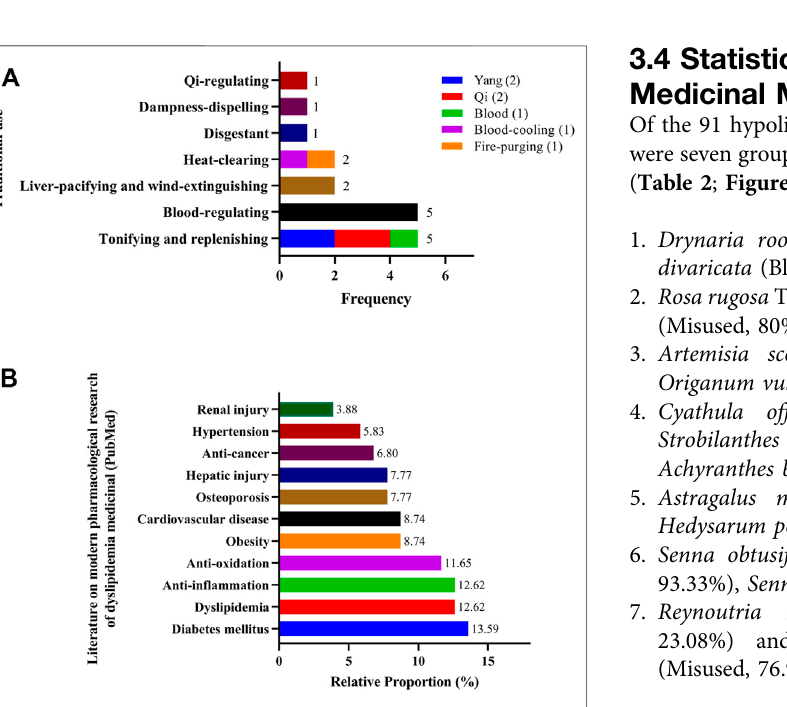
Frontiers in Pharmacology |